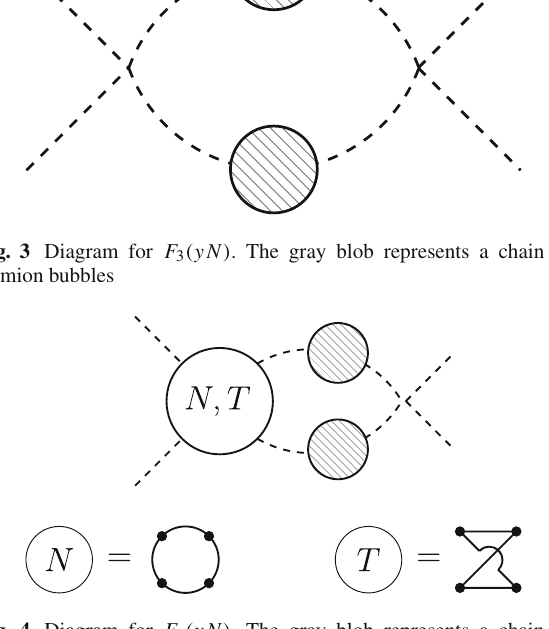
Fig. 4 Diagram for F 4 ( yN ) . The gray blob represents a chain of fermion bubbles. The labels N and T correspond to non-twisted and twisted fermion bubbles, respectively, and are pictorially represented below the F 4